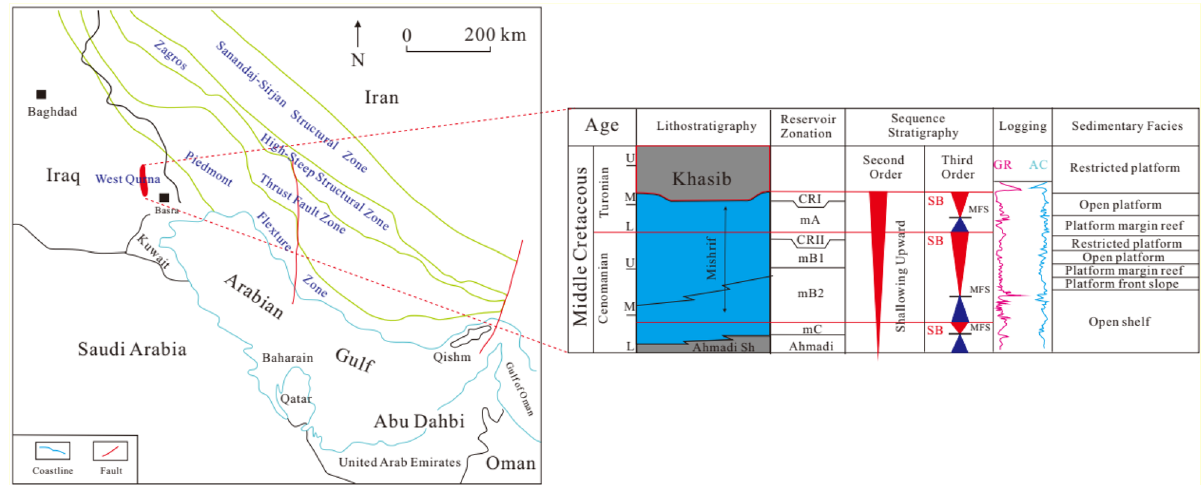
Figure 1. Regional tectonic location of study area, sequence and sedimentary characteristics of Mishirif Formation in the study